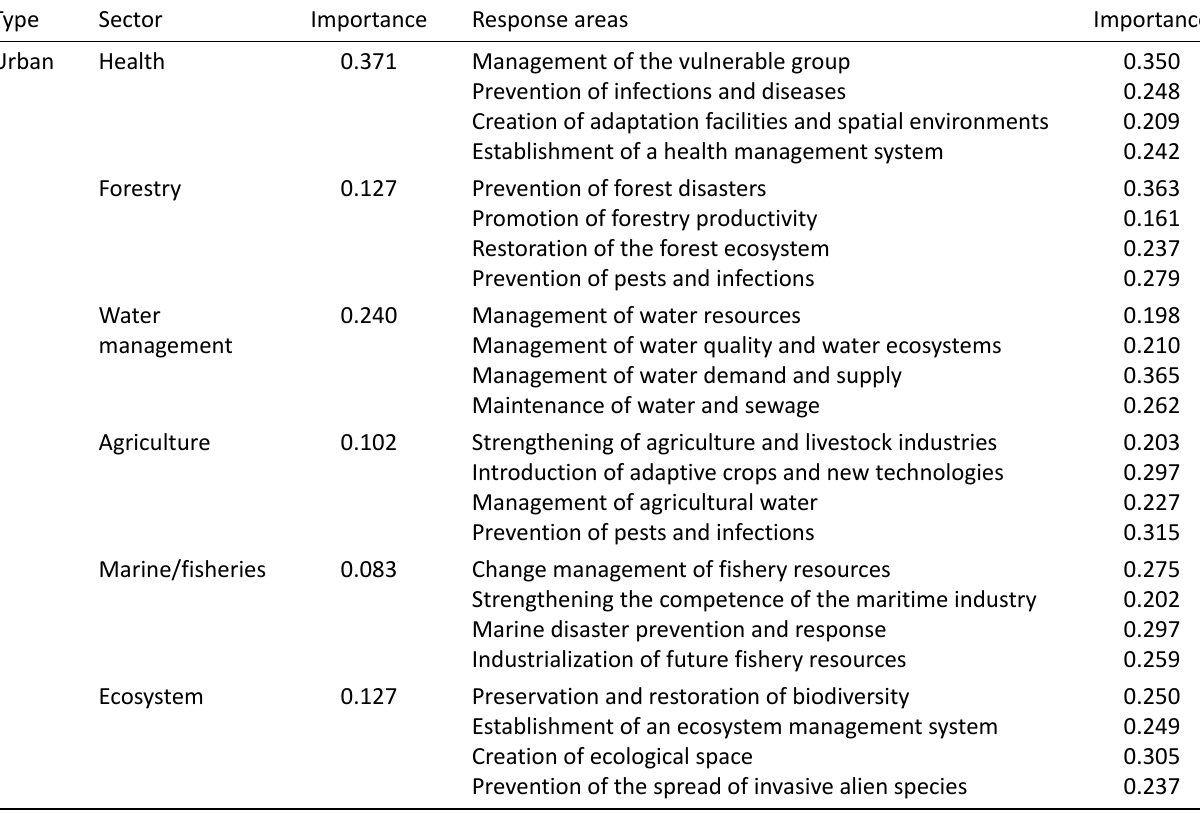
Table 7. Importance of the sector and response areas of heat wave adaptation policies by municipality type.